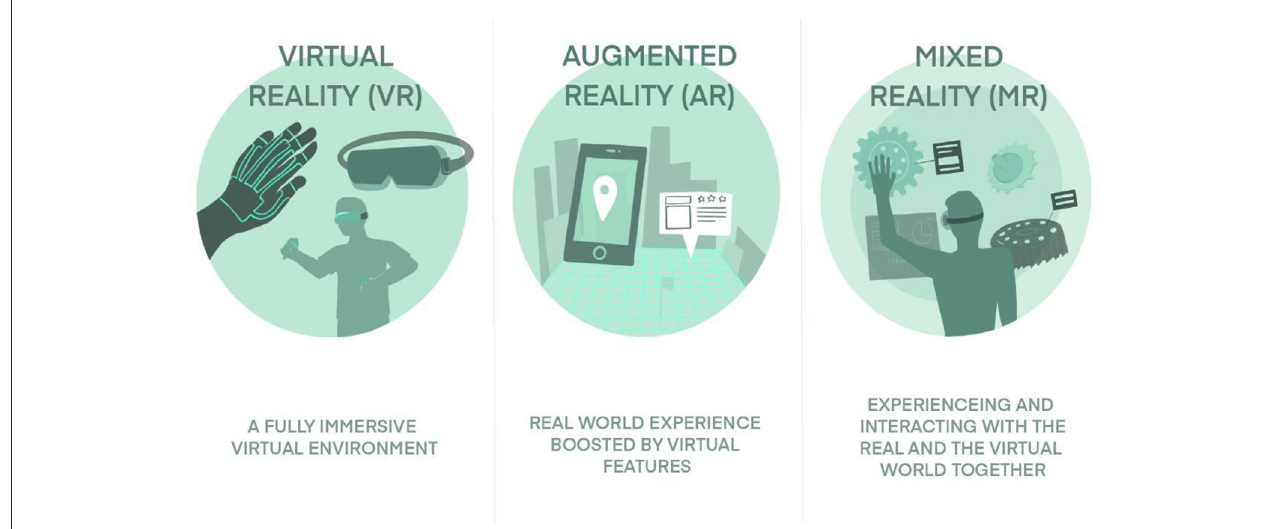
FIGURE 1 | Differentiation of immersive experience (Virtual Reality, Augmented Reality, and Mixed Reality) medical simulation